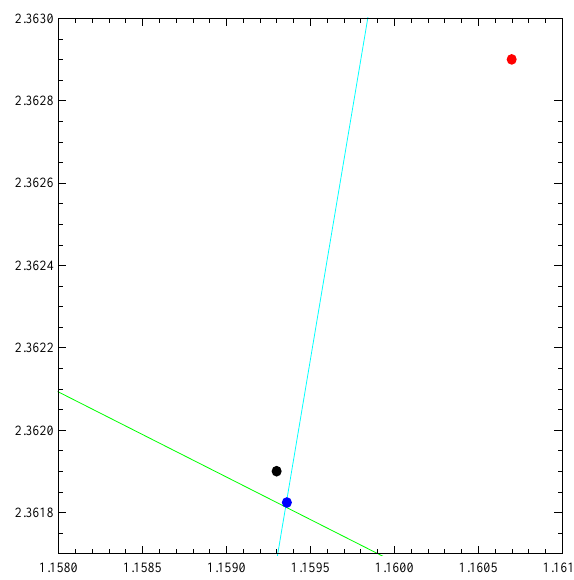
Figure 2. Magnified part of the approximated root after two